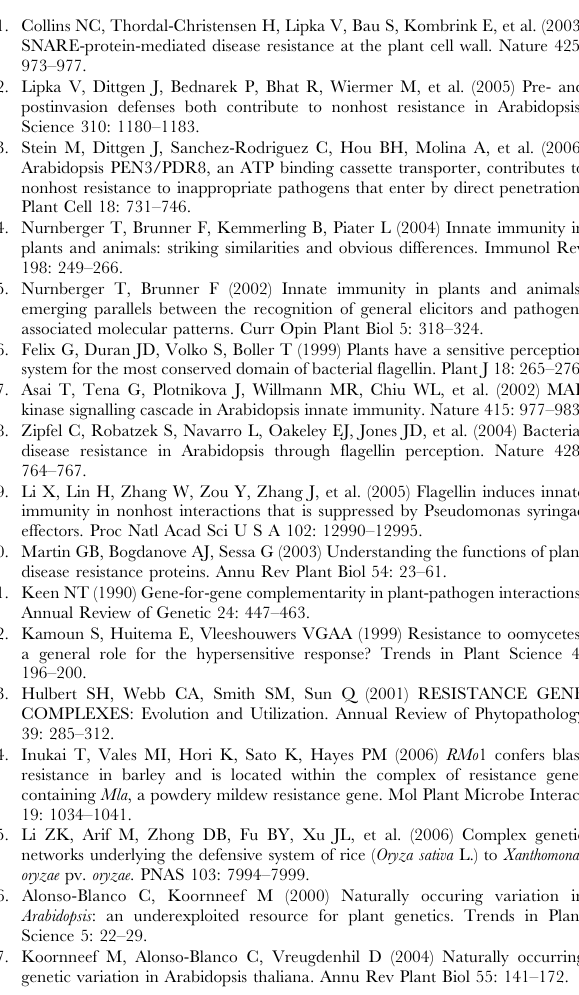
Figure S1 Analysis of the F1 progeny of reciprocal crosses between Bay-0 and Shahdara for partial resistance to Pseudomonas